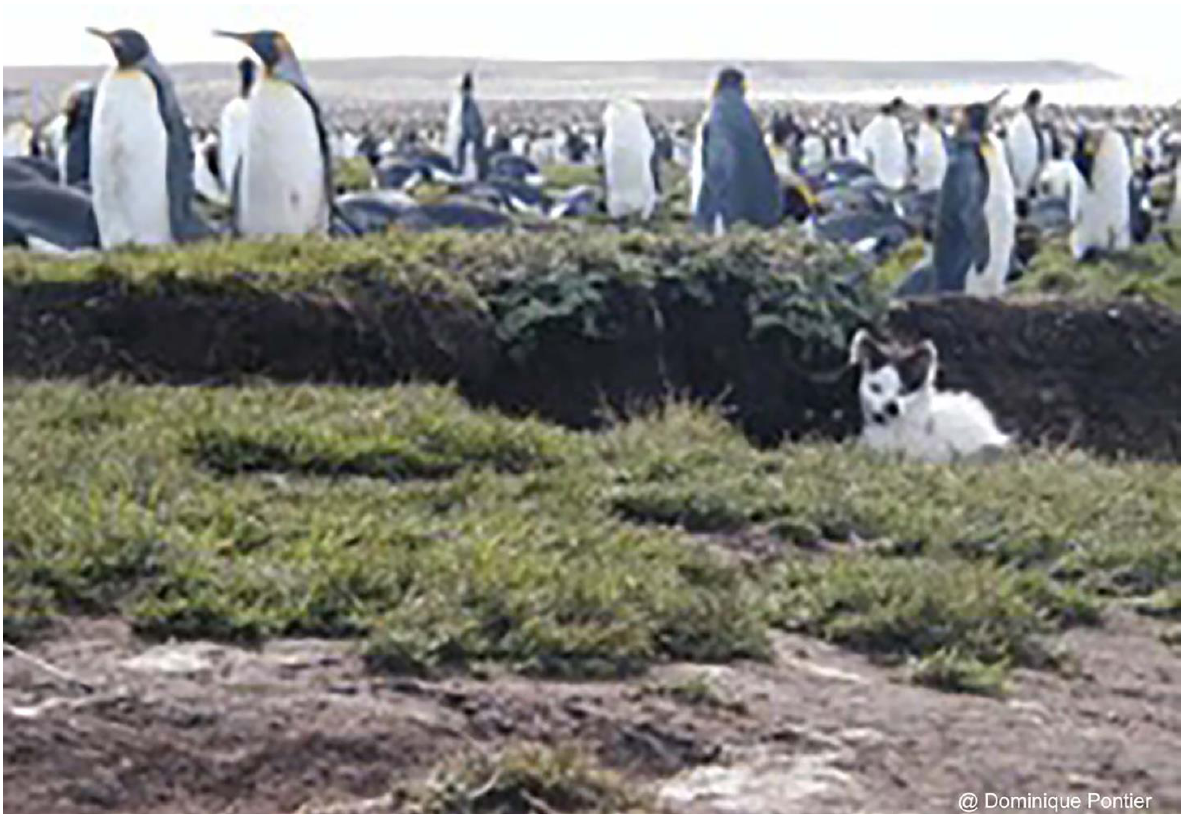
Figure 4. Kittens born at the Ratmanoff penguin farm zone (Grande Terre, Kerguelen Archipelago) (credit Dominique Pontier).